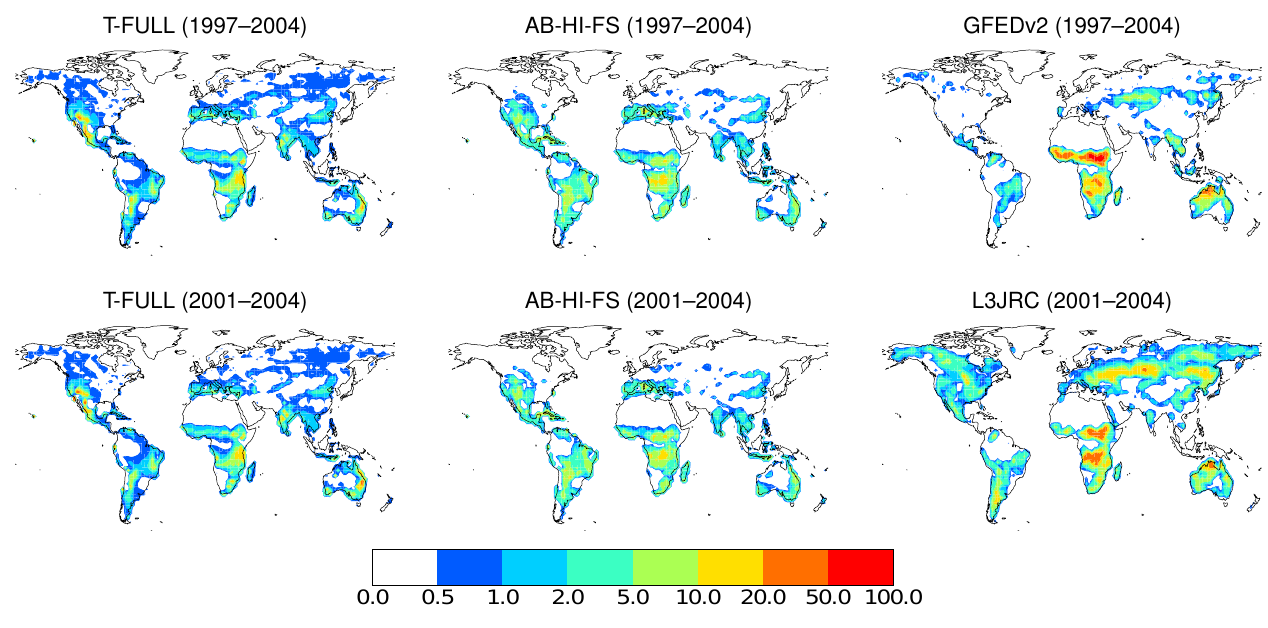
Fig. 1. Simulated annual total (wildfire plus deforestation) area burned [percentage of grid box] compared to satellite-based fire products: GFEDv2 (van der Werf et al., 2006) and L3JRC (Tansey et al., 2008). The model simulations are averaged over the corresponding observational periods (GFEDv2: 1997–2004; L3JRC: 2001–2004). Regional values for all simulations performed are given in Fig. 2.